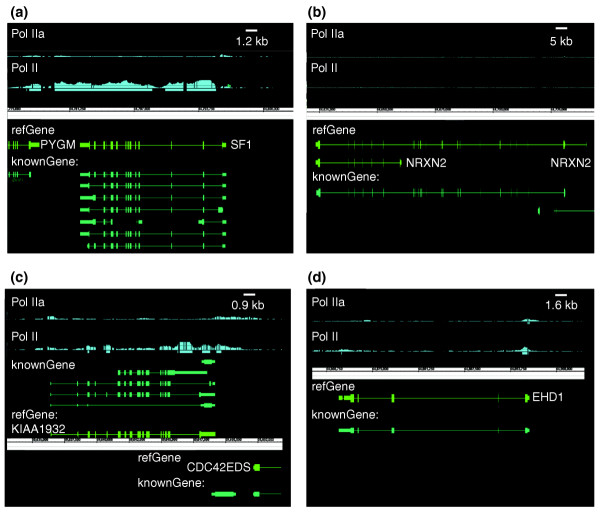
RNA polymerase II shows a variety of gene-specific enrichment patterns. Graphs plot 10log(p-value) mapped to chromosome position with the significant p-values greater than 40 indicated by the rectangle blocks below the graph. Values are plotted at every probe location. Flat lines indicate weak p-values and gaps indicate the absence of probes. The high density of probes across these genes suggest that the observed patterns are not due to probe bias. A scale bar is shown for each panel to reflect the different gene lengths displayed. RefSeq genes and knownGenes are annotated in green and blue, respectively, with thick bars representing exons and thin lines introns. Genes above the white bar are ordered 5' to 3', whereas those below the white bar are 3' to 5'. (a) On the highly expressed SF1 gene, PolIIa localizes to the first exon only. PolII accumulates across the gene with a distinctive pattern. (b) No significant signal is observed across the inactive NRXN2 locus which is near SF1 on chromosome 11. Graphs are plotted on the same scale as (a). (c) The moderately expressed gene KIAA1932 also reveals distinct accumulations across the gene. The red box highlights alternatively spliced exons. At the 3' end of the gene, some PolIIa signal is observed, probably indicative of the expression of a small gene antisense to KIAA1932. (d) Another commonly observed pattern is exemplified by the EHD1 gene. Both anti-polymerase antibodies recognize the first exon, but no other significant signal is observed across the gene until the 3' end.